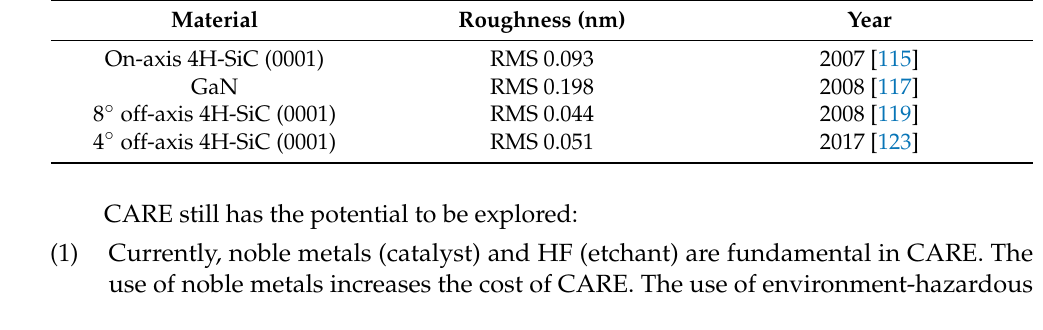
Table 5. The ultimate roughness achieved with CARE.